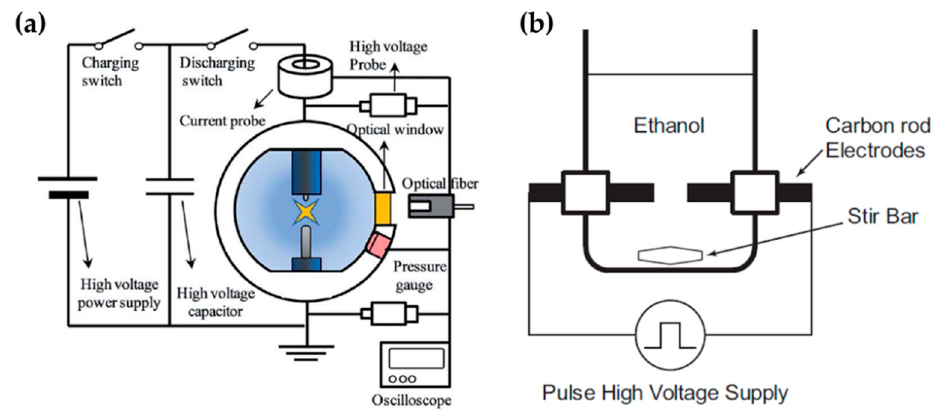
Figure 12. Schematic diagrams of the in-solution plasma systems proposed by ( a ) Lee et al. [91] and ( b ) Li et al. [110].